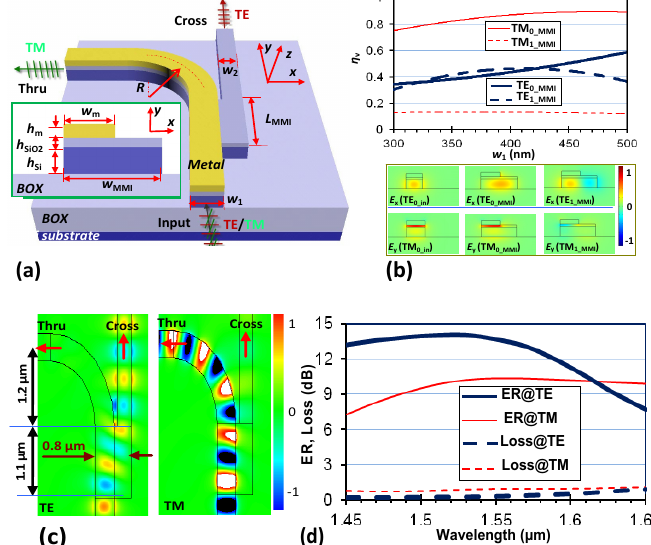
Figure 8. ( a ) Configuration of the PBS based on an MMI coupler with a silicon hybrid nanoplasmonic waveguide; ( b ) The mode excitation ratio η v for the modes in the MMI section; ( c ) the simulated light propagation in the designed PBS; ( d ) the calculated transmission responses. The parameters are: the Si core layer thickness h Si = 230 nm, the SiO 2 nano-slot thickness h SiO2 = 50 nm, the metal (Ag) thickness h m = 100 nm, w 1 = 420 nm, w 2 = 300 nm, w MMI = 800 nm, R = 1.2 μ m [30].